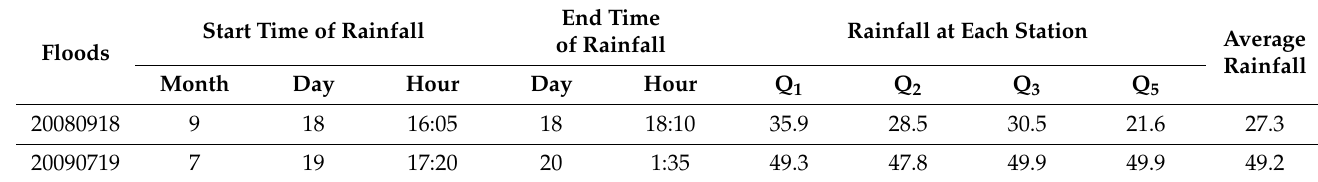
Table 2. Rainfall conditions of two flood